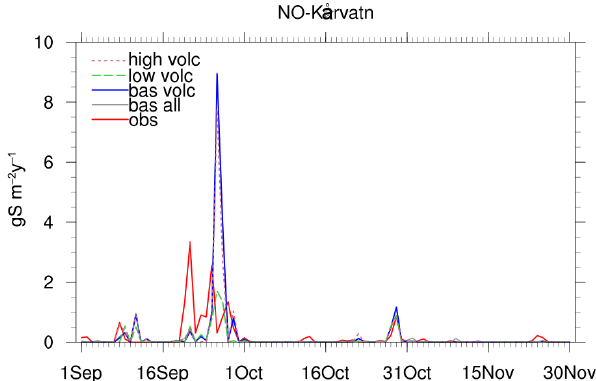
Figure 7. The same as Fig. 4, but September–November 2014 daily time series of SO x total deposition at the Kårvatn station in